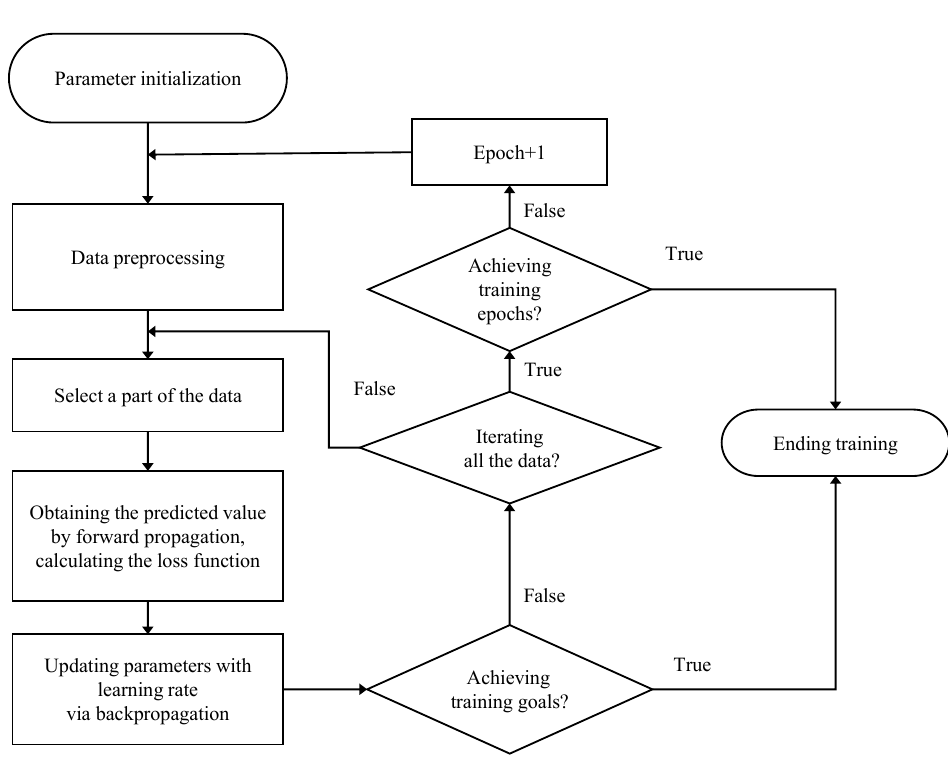
Figure 12. Neural network training process flow chart. The total dataset comprises the piezoelectric ceramic operating data, with 16,020 sets. During the experiment, set the Batch Size to 32 and the learning rate to 0.01. After 5000 epochs